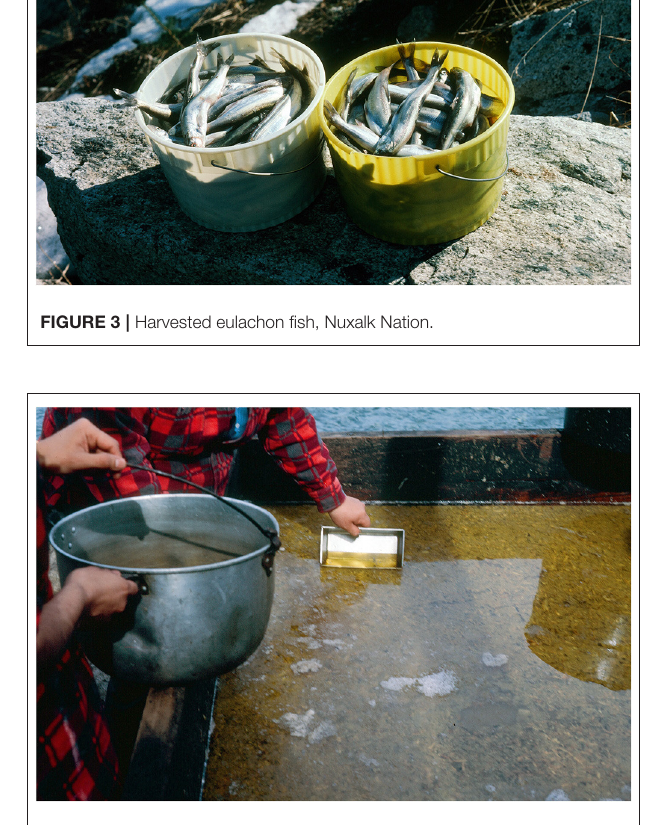
FIGURE 4 | Skimming eulachon grease from the surface of the cooking bin, Nuxalk